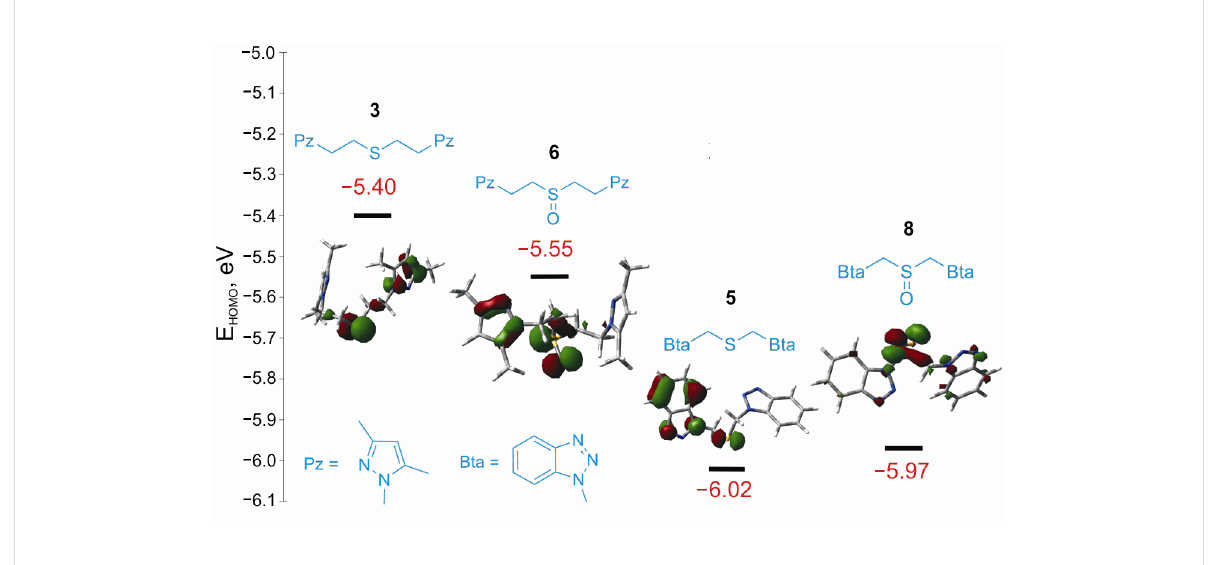
Figure 1: Energies and isosurfaces of the highest occupied molecular orbitals (HOMO) of azole-containing thioethers and sulfoxides according to DFT calculations (BP86 functional, TZVPP basis set).